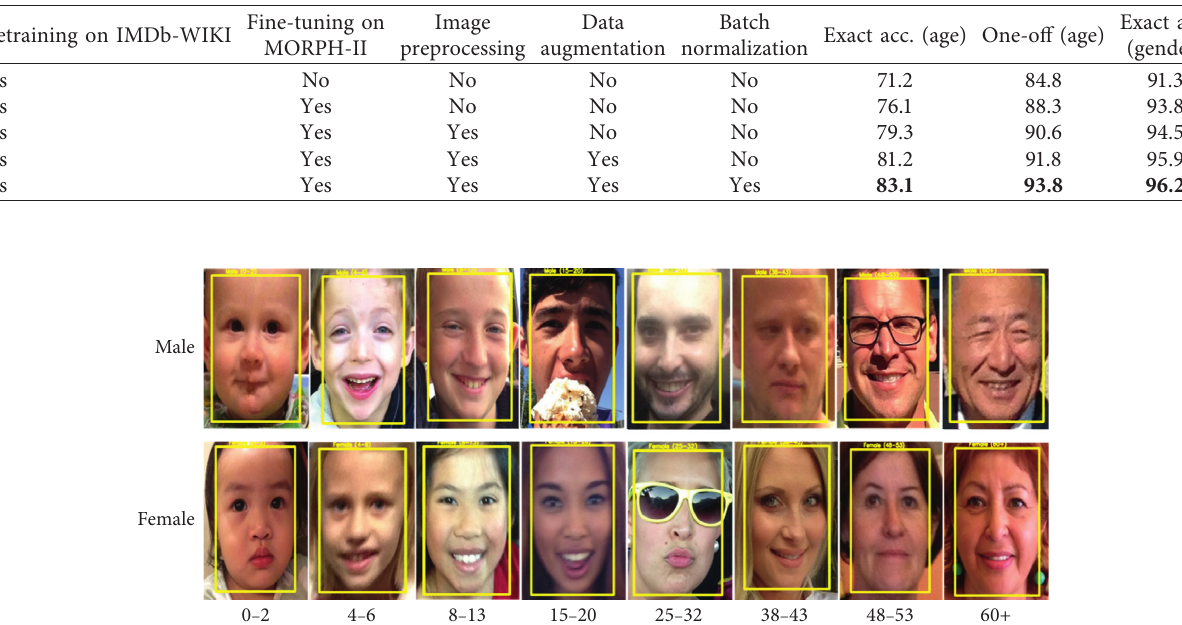
Figure 7: Samples of face images with correct age group and gender classifications.